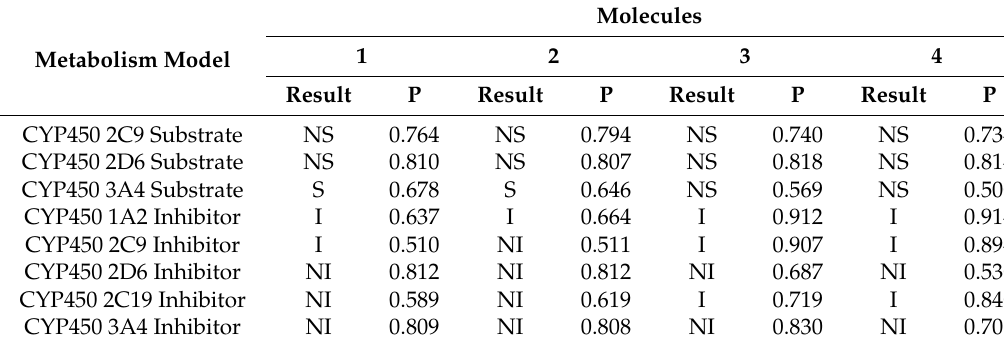
Table 5. Prediction of